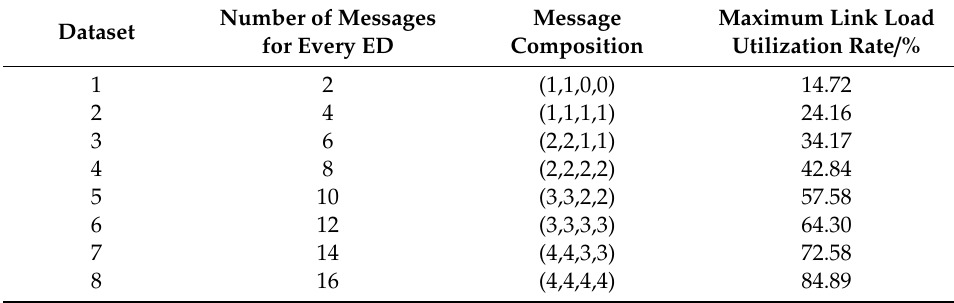
Table 4. Message distribution of four kinds of time-triggered tra ffi